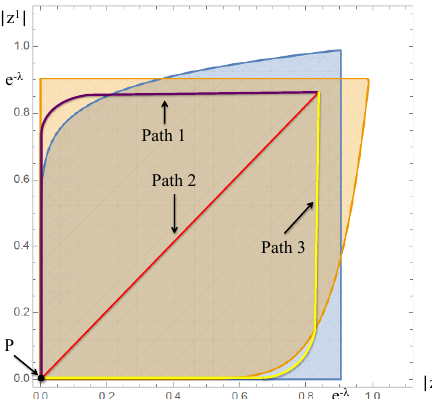
Figure 7 . Real slice through two intersecting divisors located at z 1 = e 2 (cid:25) i t 1 =0 and z 2 = e 2 (cid:25) i t 2 =0. The intersection point is the origin P = fj z 1 j = j z 2 j = 0 g . The shaded areas show the two overlapping regions (2.67), (2.69) a path to the singularity at the origin can pass through, in order that the growth can be evaluated using (2.66), (2.69) for the constant (cid:21) set to (cid:21) = 0 : 1. Three paths of di(cid:11)erent nature with respect to this are